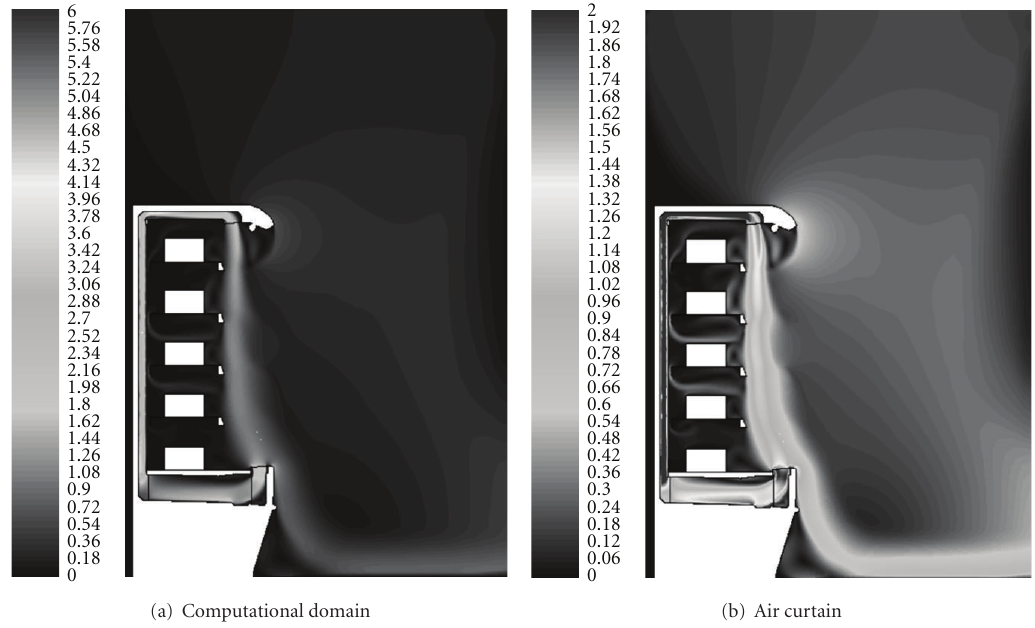
Figure 11: Velocity field numerical predictions, v [ms − 1 ]—OPTg case